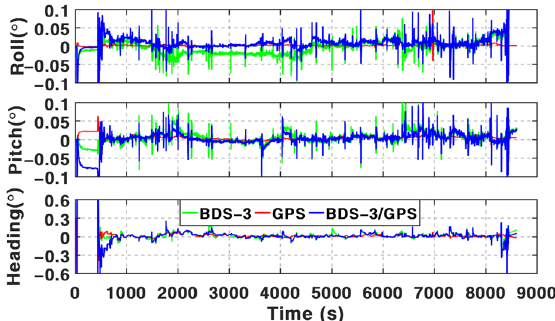
Figure 23. Attitudes differences between undifferenced PPP/INS/ODO TCI and BSSD PPP/INS/ODO TCI.